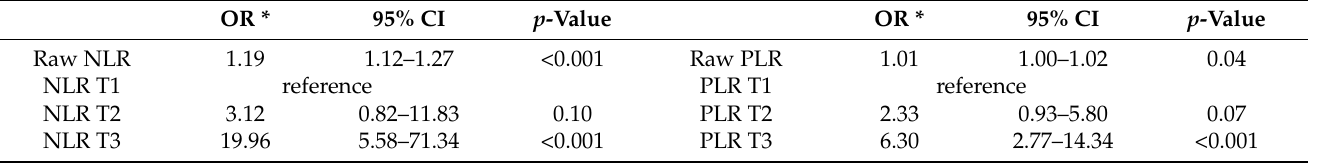
Table 2. Multivariate analysis showing the impact of NLR and PLR on hematoma expansion.